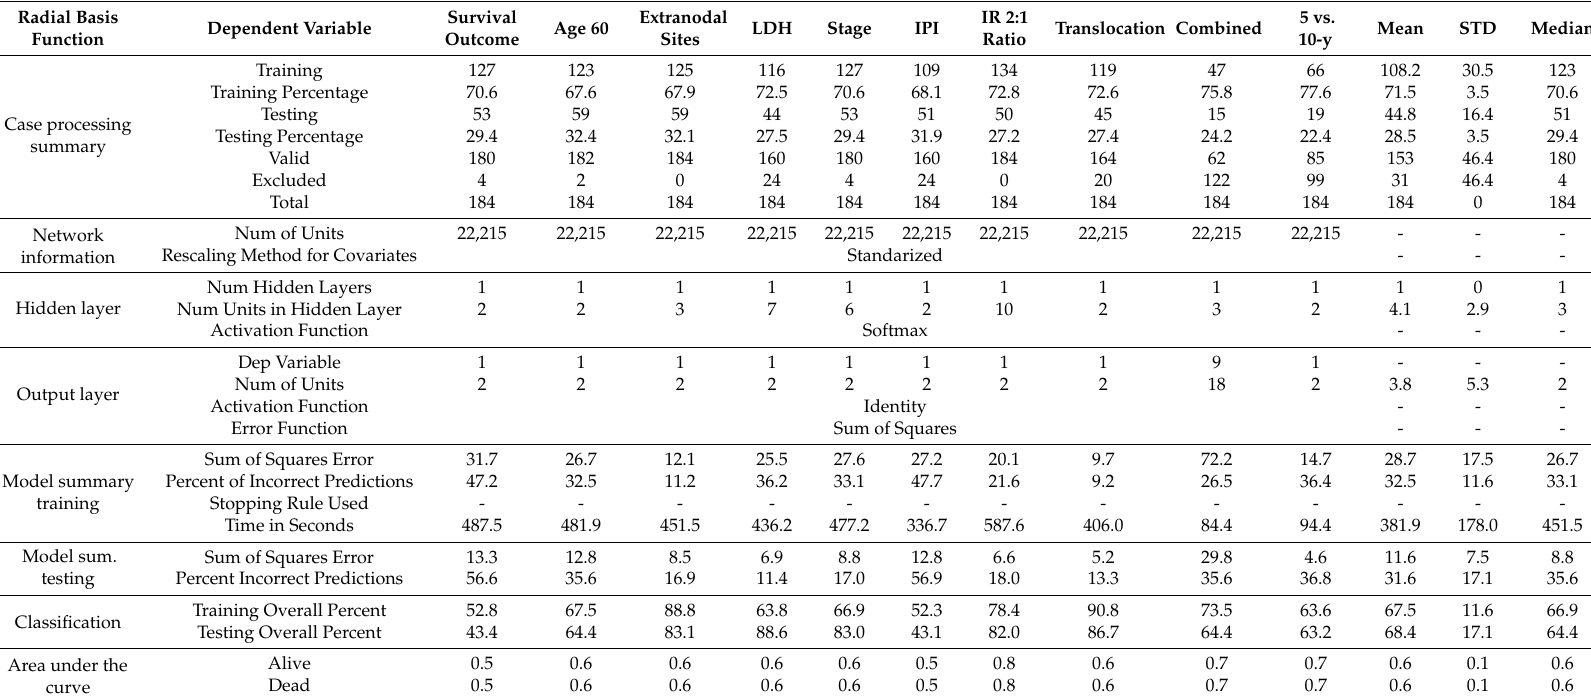
Table 4. Radial basis function analysis